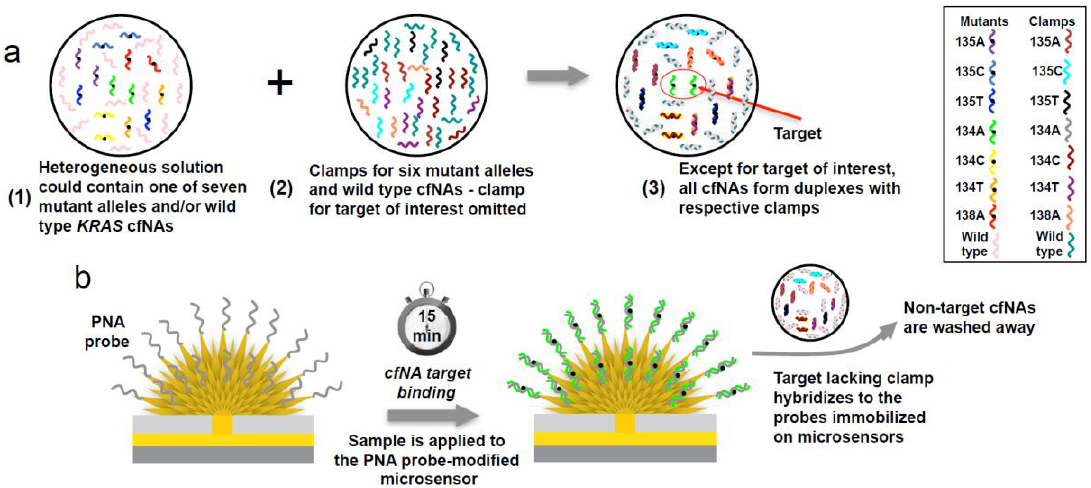
Figure 2. Schematic representation of the clamp assay used to detect KRAS mutations. ( a ) The sample (1) was mixed with PNA clamp sequences (2) to sequester the wild-type sequence and all of the mutated sequences different from the target KRAS sequence (3) (134A—green in the shown example). ( b ) The sample was then adsorbed onto the PNA probe-modified microelectrode and only the target KRAS sequence hybridized to the PNA probe. The other six mutants and wild-type nucleic acids were not able to bind and were washed away. Adapted with permission from ref. [125].